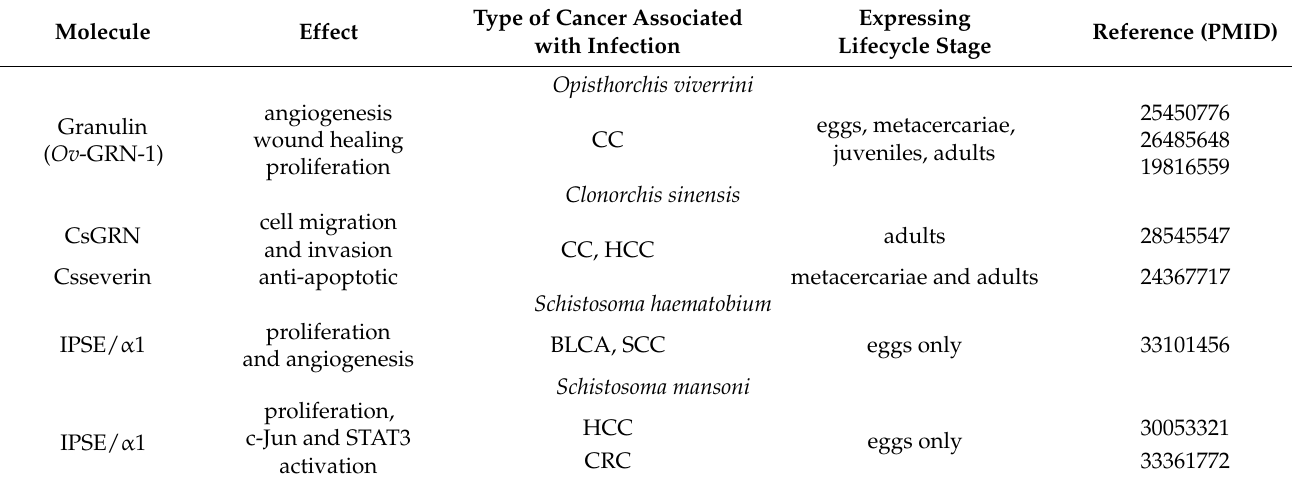
Table 1. Table summarizing the identified parasite-derived proteins with suspected pro-carcinogenic activity. BLCA, bladder cancer; CC, cholangiocarcinoma; CRC, colorectal carcinoma; HCC, hepatocellular carcinoma; SCC, squamous cell